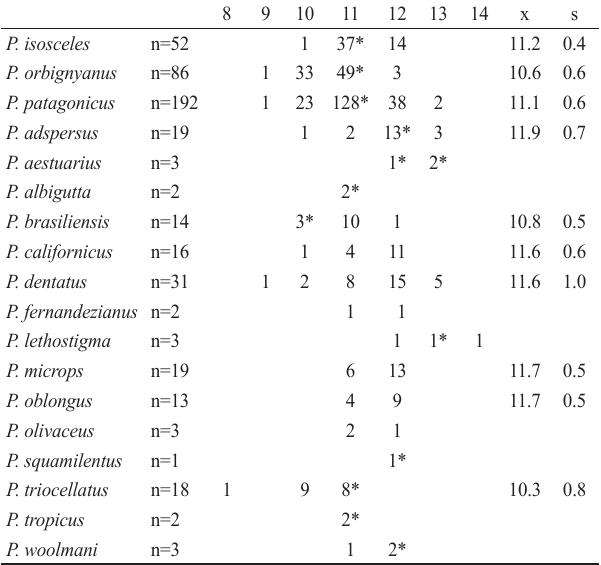
Tab. 4. Frequency comparison for counts of pectoral-fin rays in Paralichthys species. *include